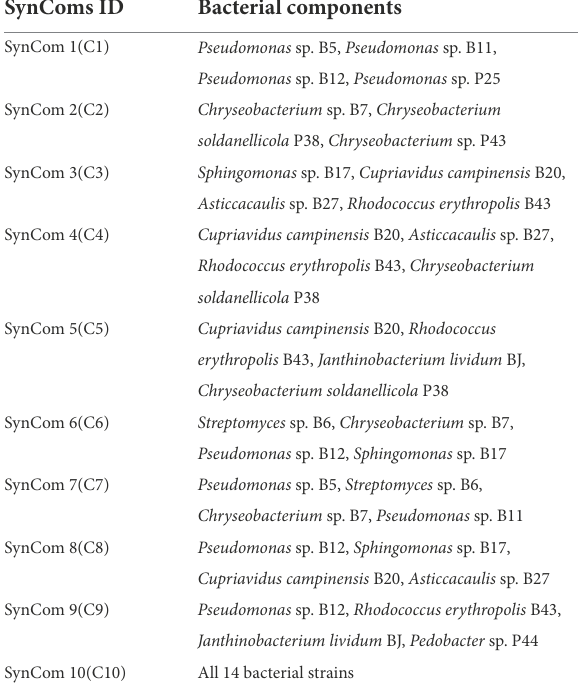
TABLE 1 The designed synthetic microbial communities (SynComs) in this study. SynComs